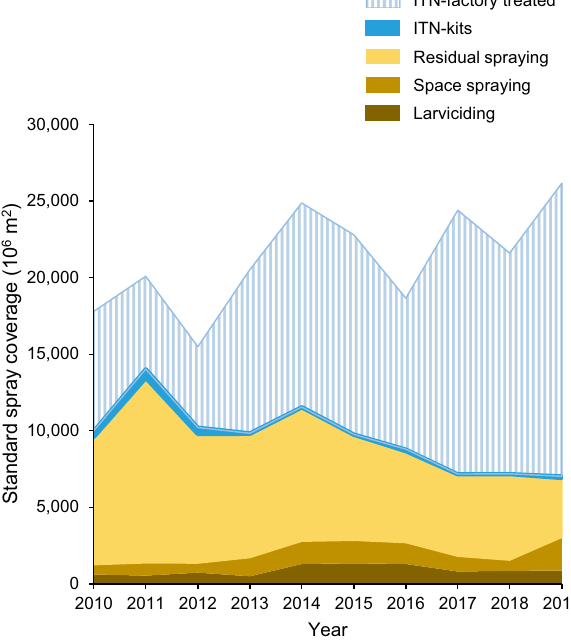
Figure 2. Area graph of global use of vector control insecticides by intervention type. Results are pooled for the four selected diseases and are expressed in standard spray coverage.